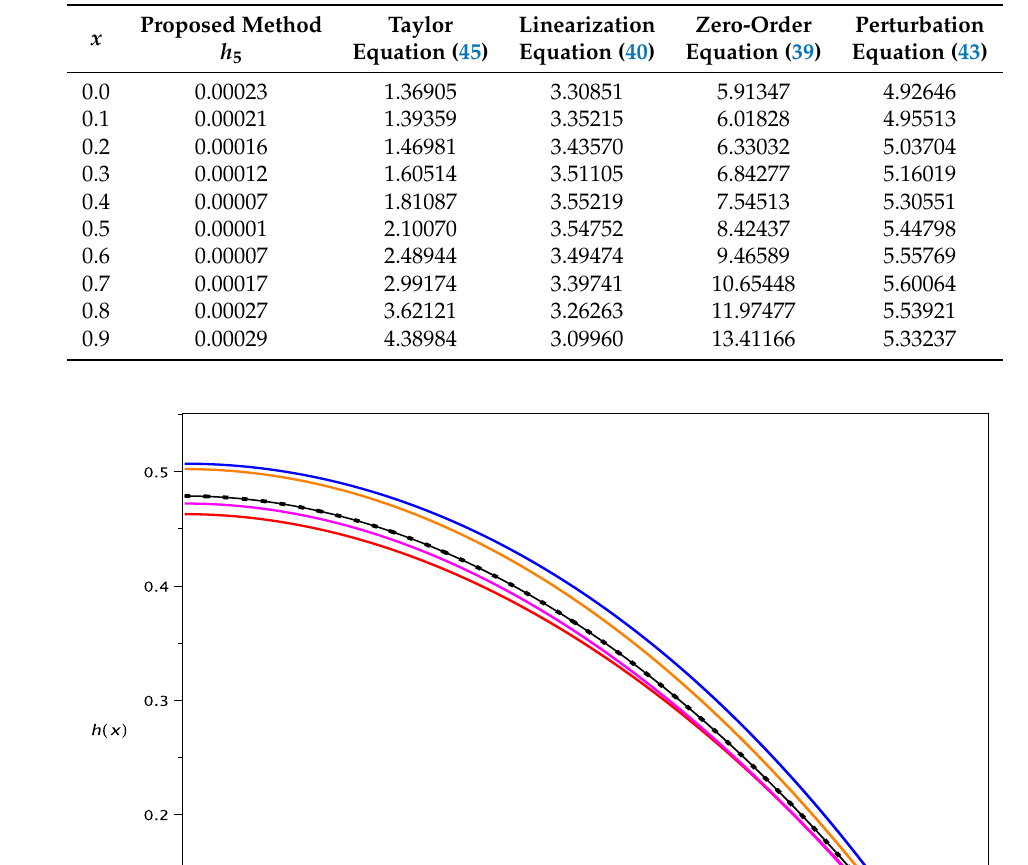
Table 2. Comparison of relative errors obtained by different numerical schemes for problem (2) with parameters a = 1.6, b = 1.7.